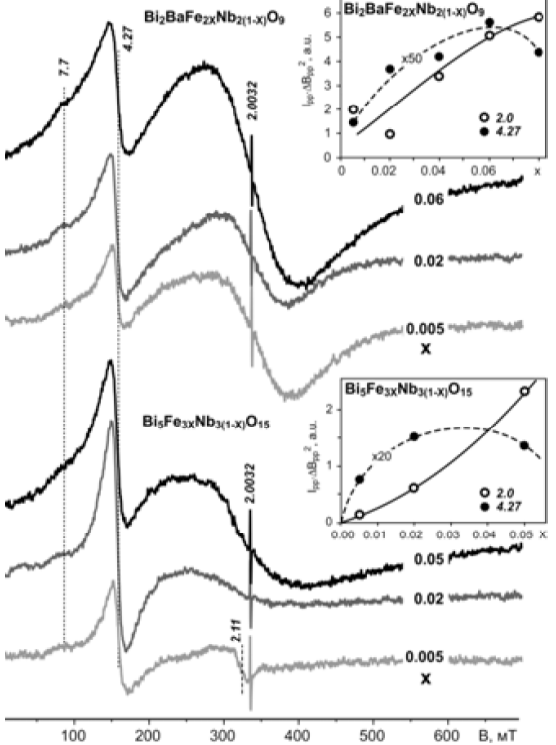
Fig. 5 . ESR spectra of the samples of the Bi Ba  2 Nb Fe O and Bi Nb Fe O solid solutions 2-2 x 2 x 9-  5 3-3 x 3x 15-  at various values of index x,  Bpp width of an indi- vidual line is 15 mT. The inset shows the dependences of the integral intensities of the lines with g = 4.27 and 2.0 on the x value.